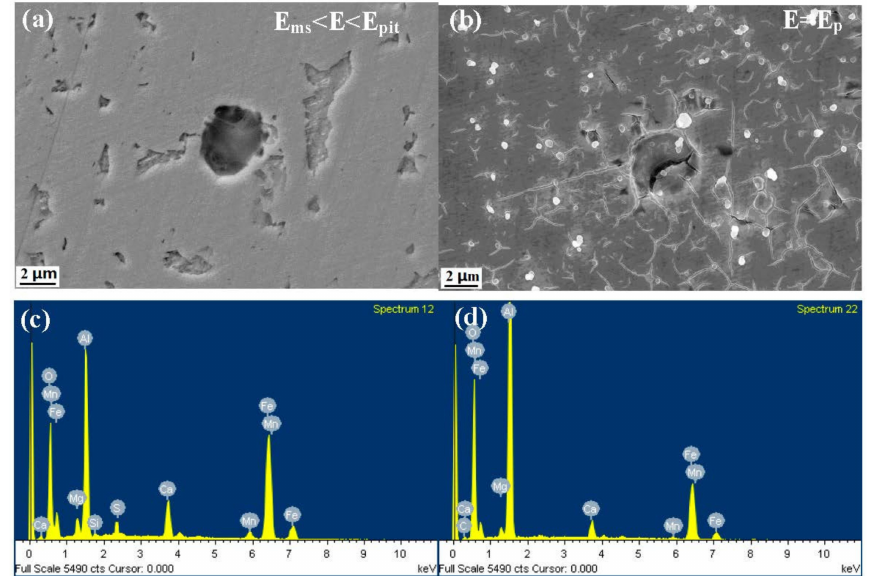
Figure 5. The morphology and EDS analysis of metastable pits at type B inclusion sites after the potentiodynamic polarization test. ( a , c ): E ms < E < E pit ; ( b , d ): E = E pit .